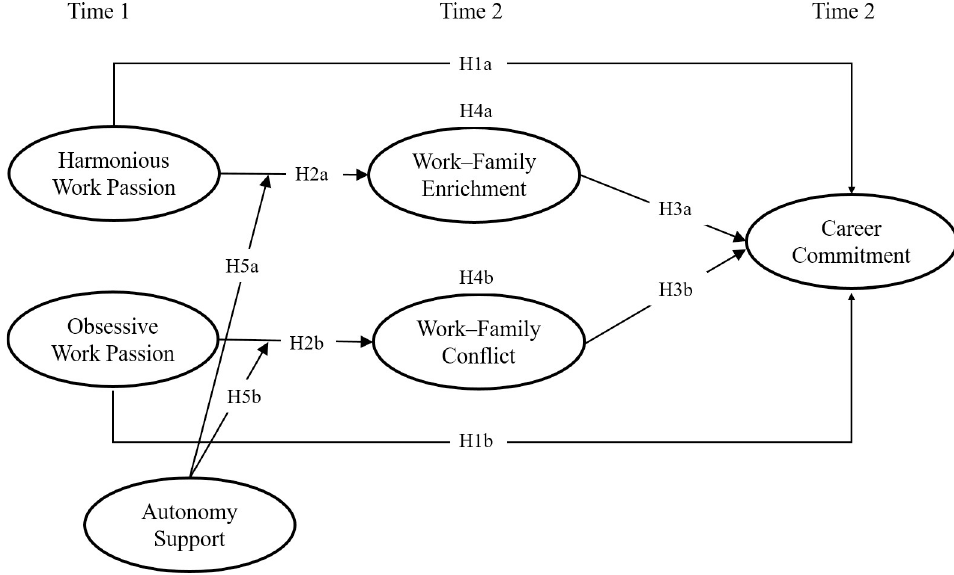
Fig 1. The hypothesized research